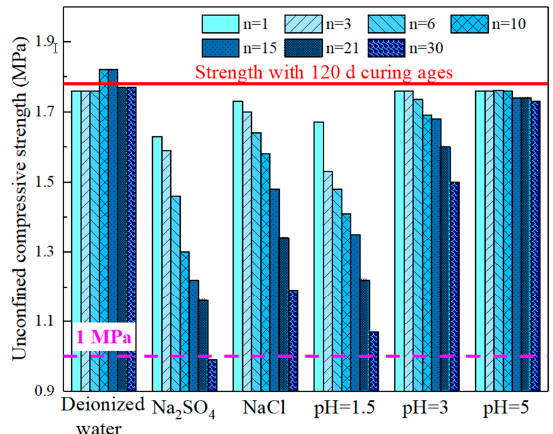
Figure 7. Unconfined compressive strength of the PG-based backfill specimens at different drying-wetting cycles and exposure solutions.